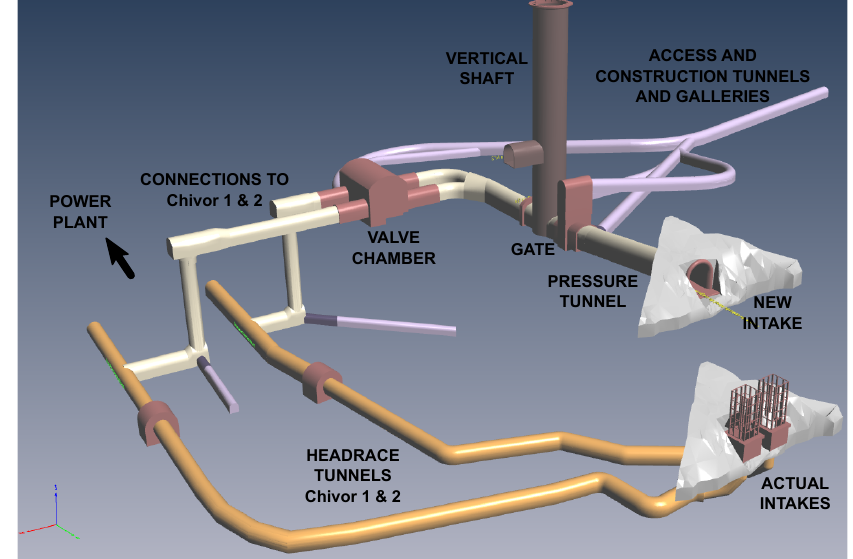
Figure 4. Chivor intake